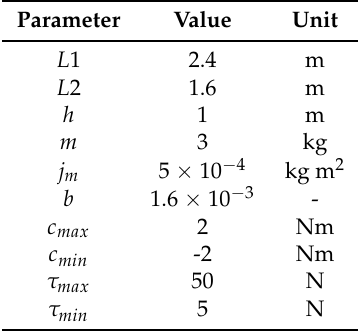
Table 1. Values for the input parameters.